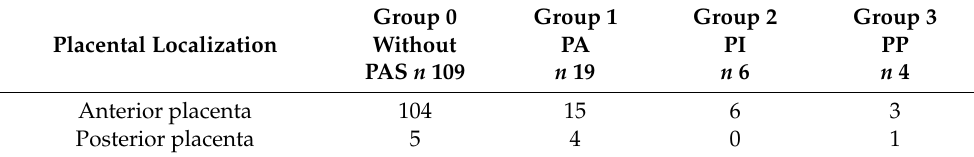
Table 4. Placental